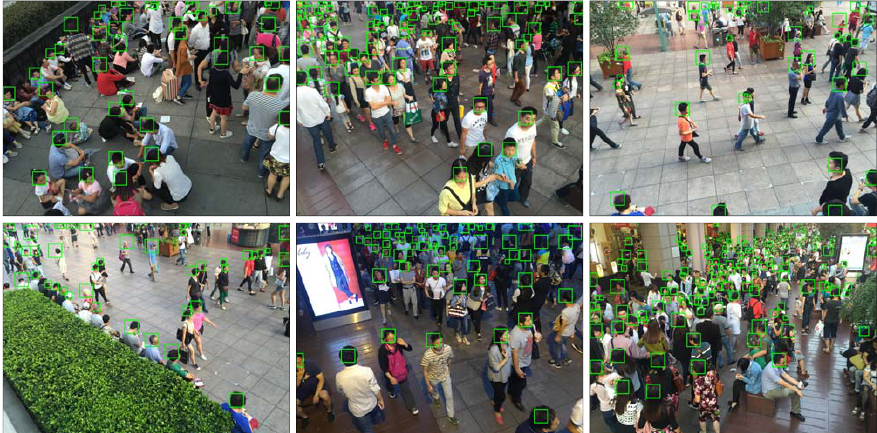
Figure 4. Qualitative results on the ShanghaiTech Part